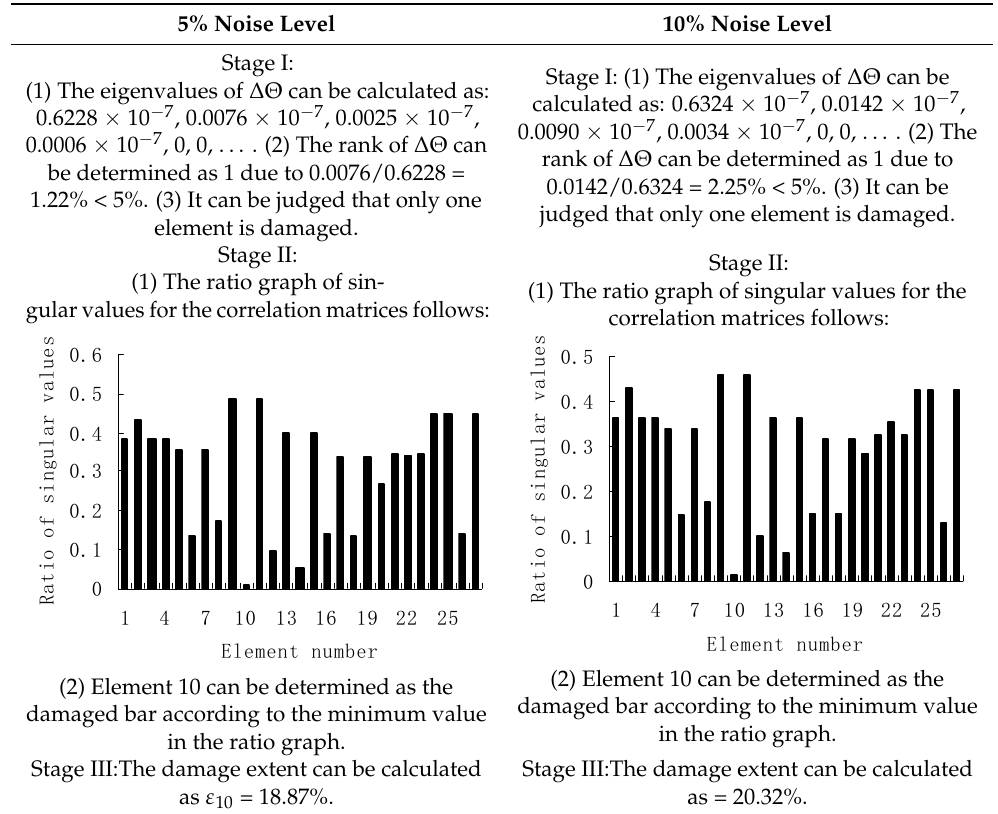
Table 3. The damage assessment results by the proposed multiple-stage dynamic flexibility analysis method when element 10 is damaged.